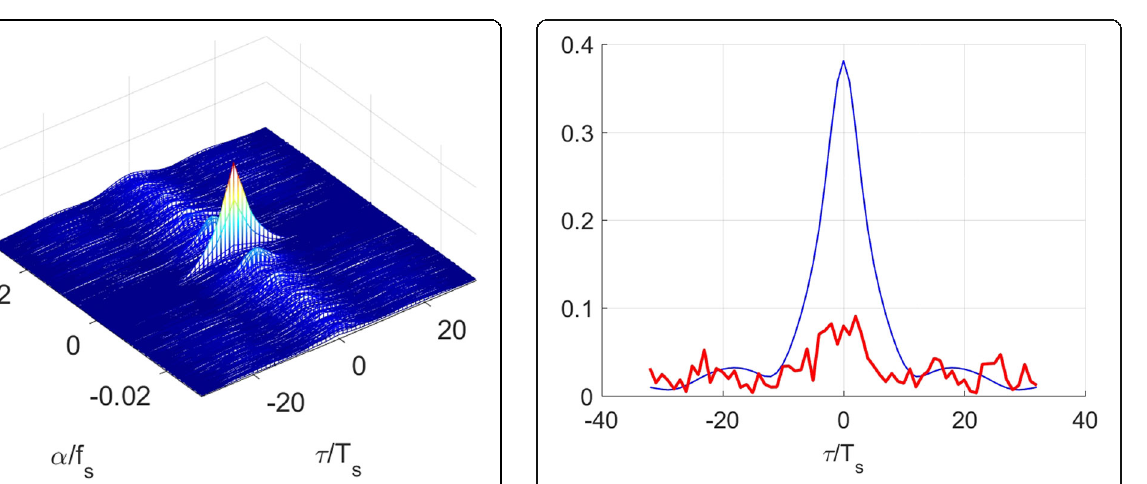
Fig. 4 Case A: magnitude of the cyclic correlogram of the time-warped data, with SNR ¼ 10 dB, as a function of α / f s and τ / T s ð f s ¼ 1 = T s Þ